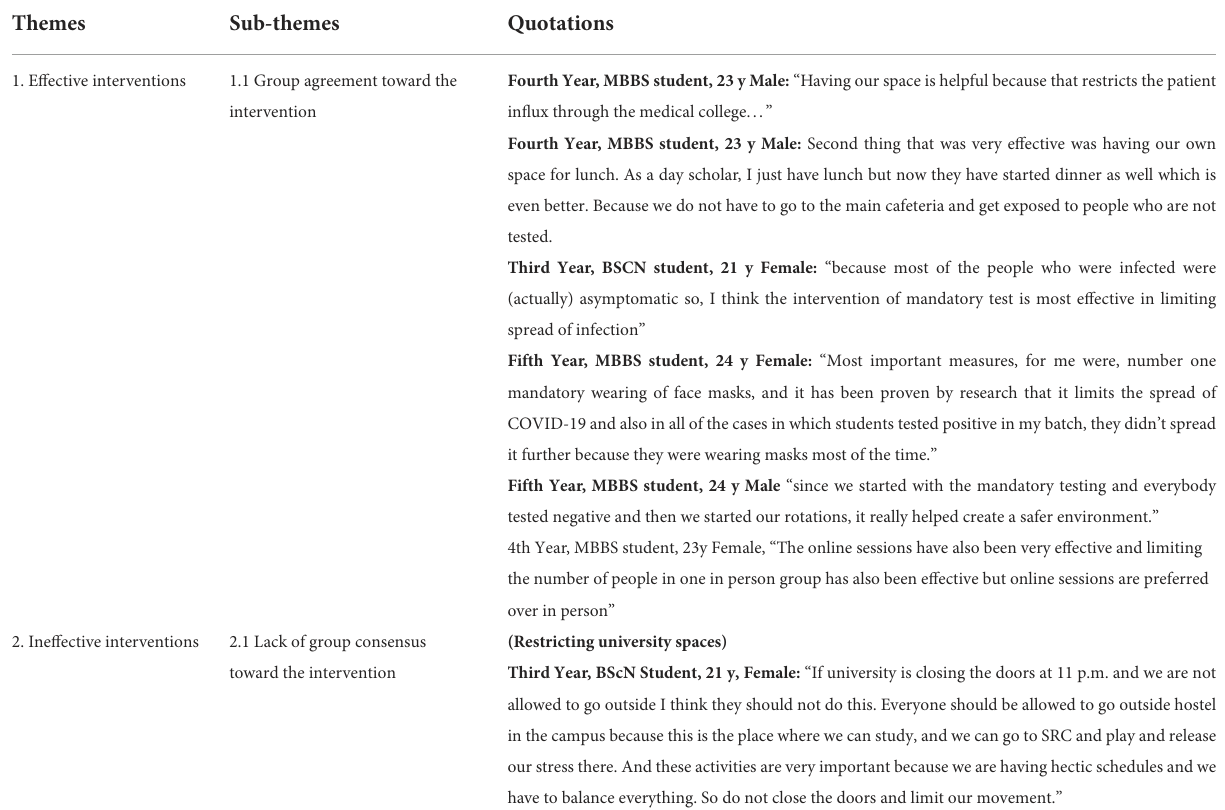
TABLE 3 Representative student quotations corresponding to themes and